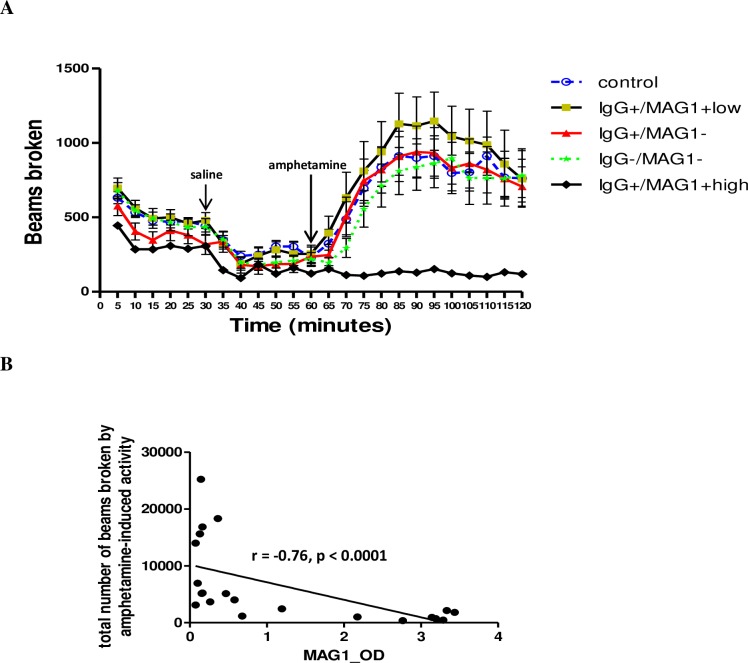
(A) Mice with high MAG1 level showed no response to amphetamine-triggered activity.Mice were subjected to three successive (habituation, saline injection and amphetamine injection) sessions with their locomotor activity recorded throughout. D-Amphetamine sulfate: 2.5 mg/kg body weight. (B) MAG1 antibody level inversely correlates with amphetamine-induced locomotor activity (Spearman’s correlation analysis). Error bars denote SEM. For the MAG1+high group the range is too low to be visualized (range of SEM, 3.78 to 15.34).